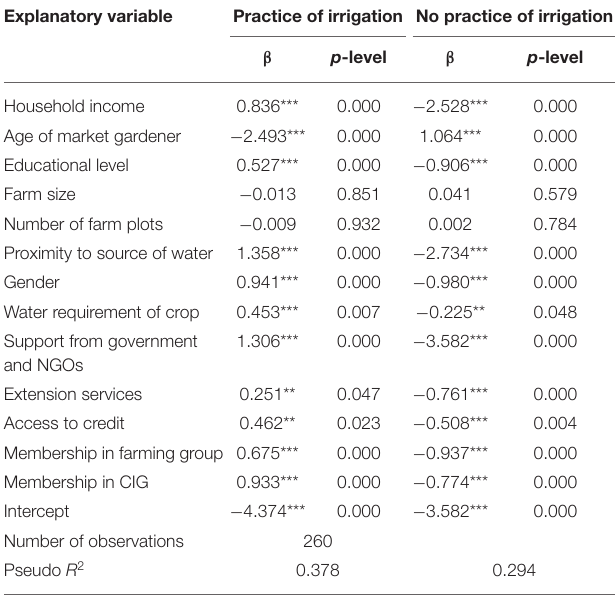
TABLE 5 | Relationship between irrigation practices and adaptation to climate change induced water scarcity/insecurity. Explanatory variable